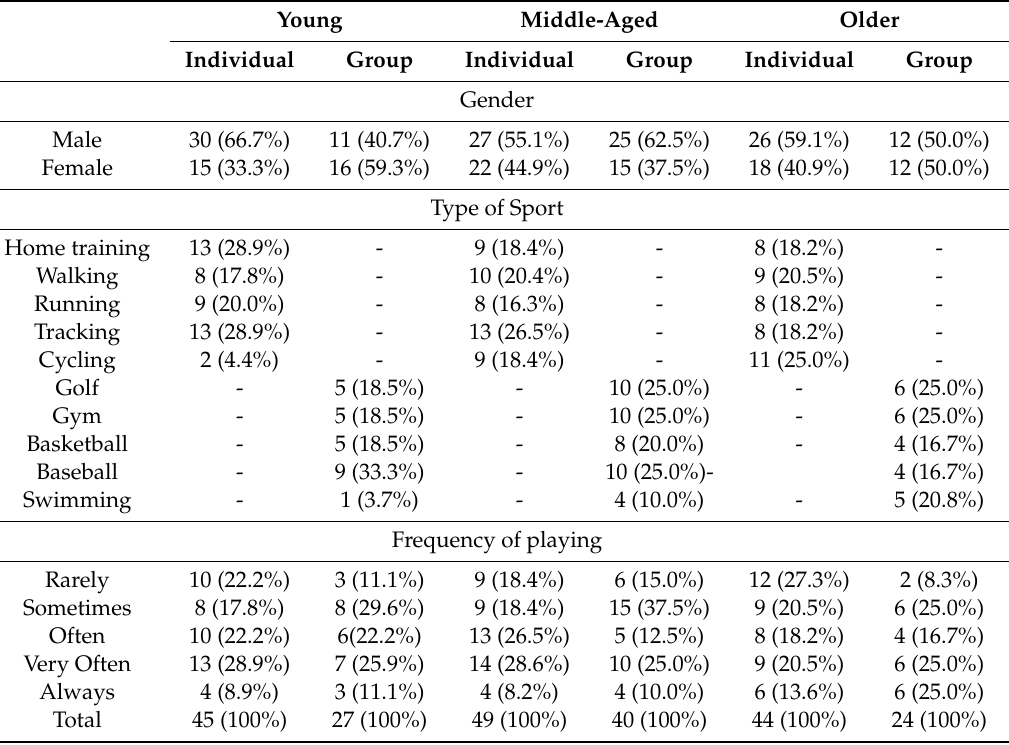
Table 1. Descriptive statistics by age and type of